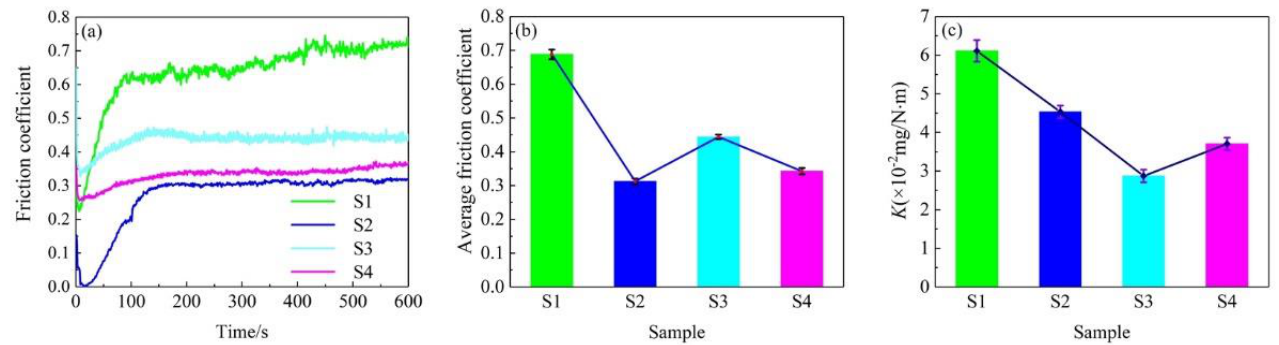
Figure 5. Variation of friction coefficient and wear rate. ( a ) Friction coefficient vs. time; ( b ) Average friction coefficient; ( c ) wear rate.